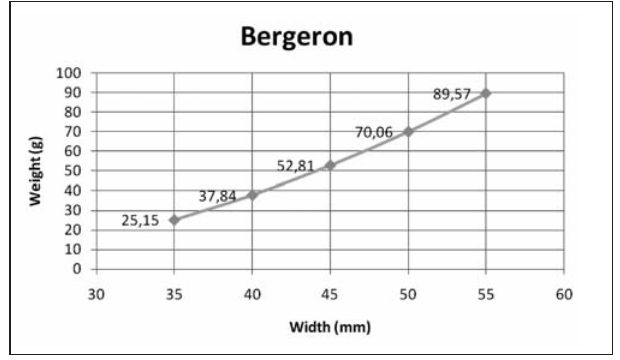
Fig. 30: Weight values calculated from the width-weight